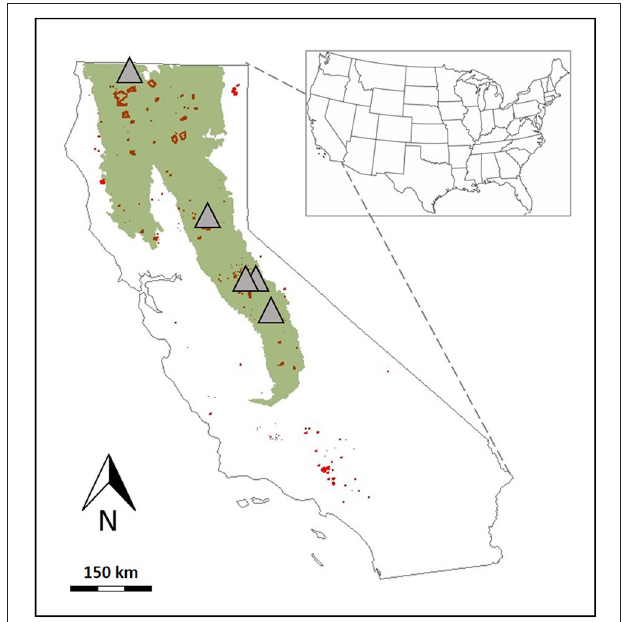
FIGURE 1 | Map of California, USA showing Sierra Nevada mixed-conifer vegetation type (green polygon), fires occurring between 2014 and 2015 (red polygons), and locations of the five wildfires from which data were collected for this study (gray triangles). Inset map shows the location of California in the continental United